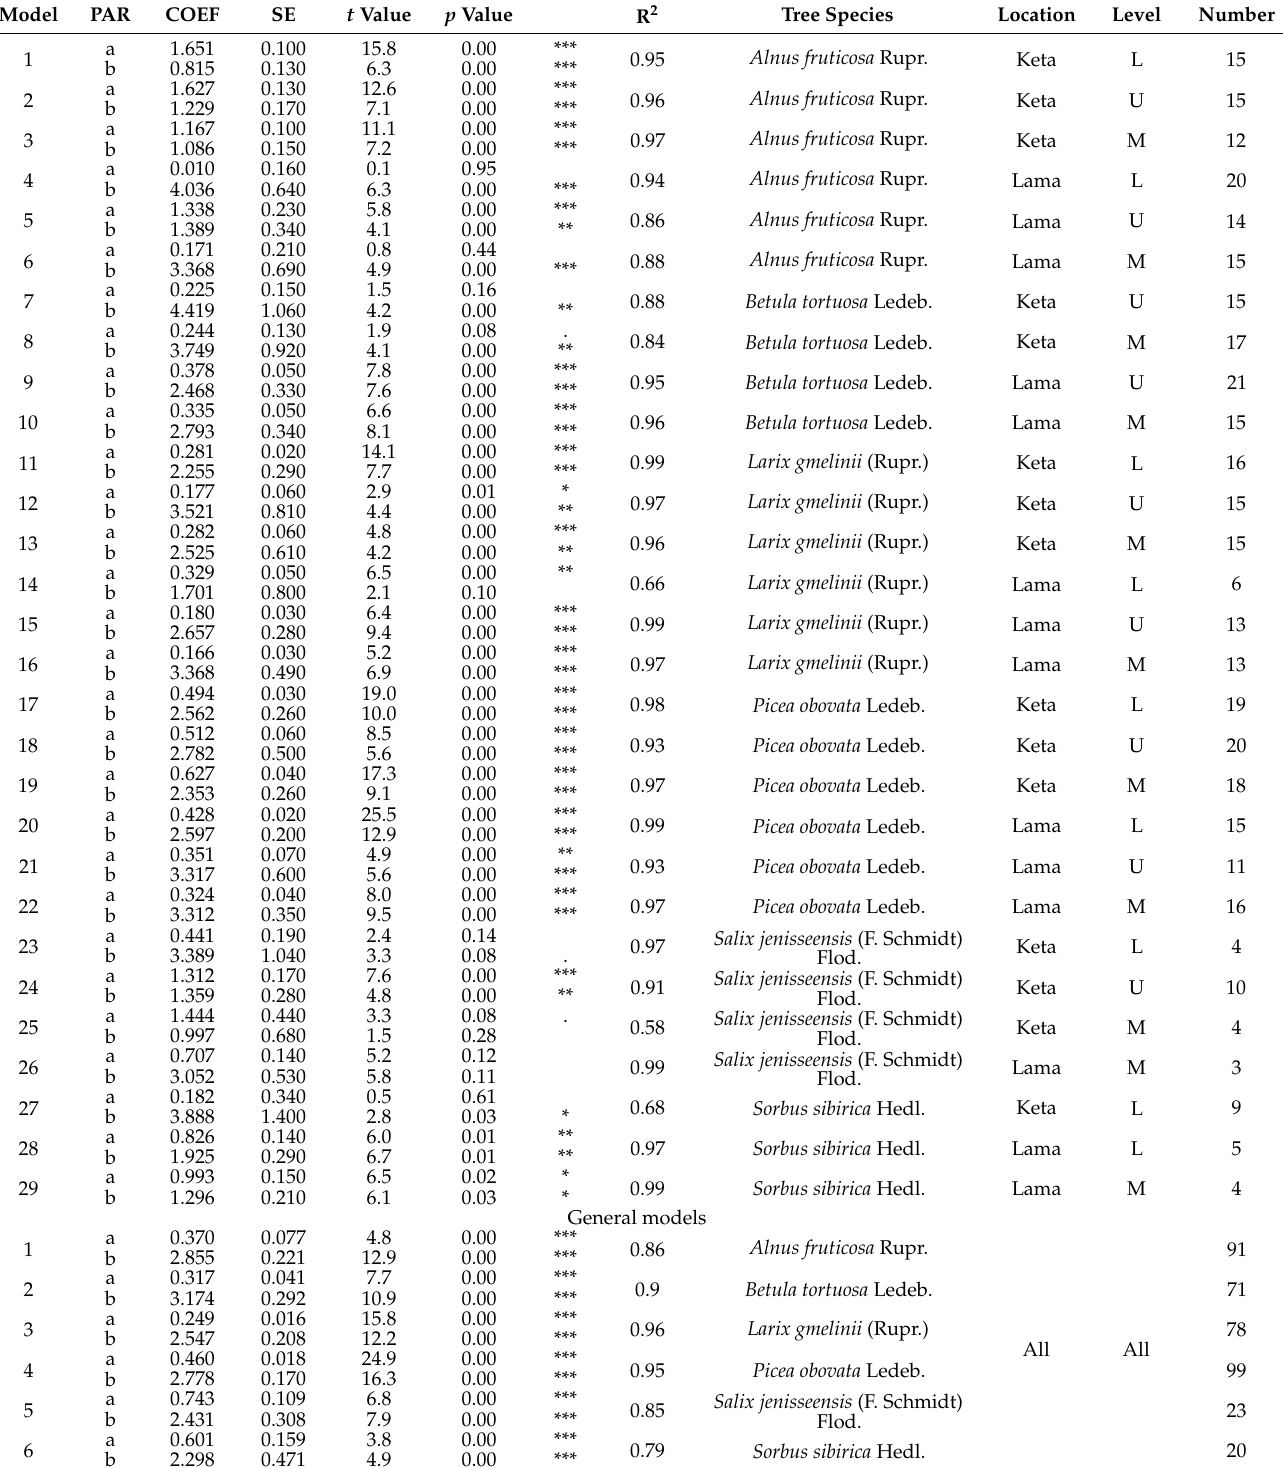
Table 2. Statistical parameters of derived crown radius-height models (Model—identification number of the derived model, PAR—coefficient in Equation (2), COEF—value of the coefficient in Equation (2), SE—standard error, t value— t -value of Student’s test of coefficient, p value—probability of t value and its significance as follows: .—90%, *—95%,